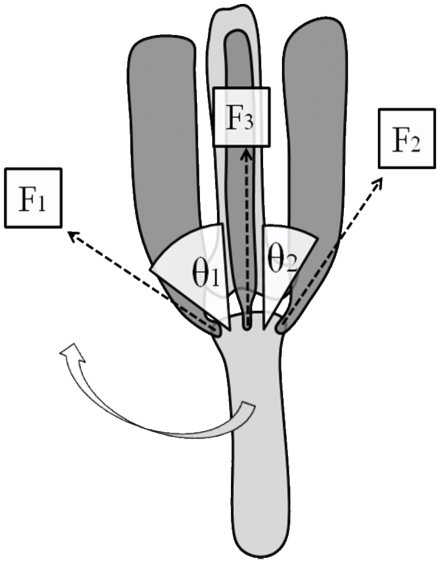
Schematic representation of a movement arc (curved arrow) elicited by one bone (light grey) with respect to another and brought about by contraction of multiple muscles (dark grey) with varying forces (F) with differing angles of insertion (θ).